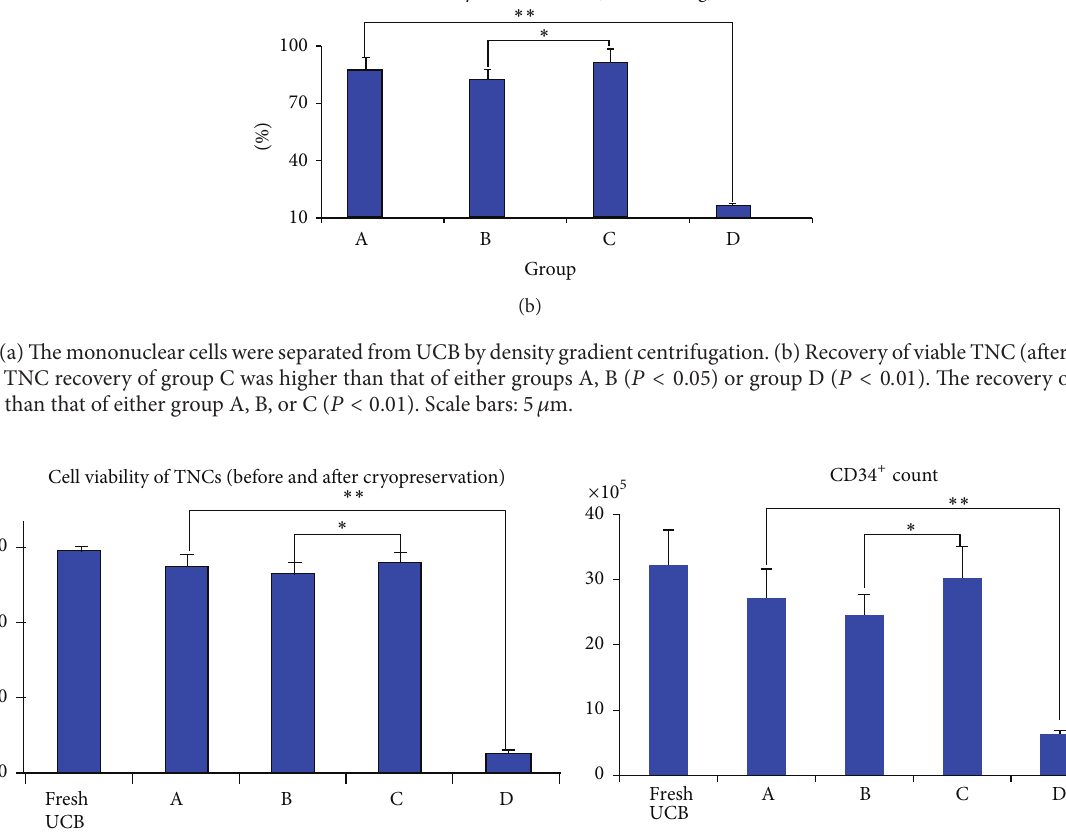
of group C was lower than that of either group A ( 𝑃 < 0.05